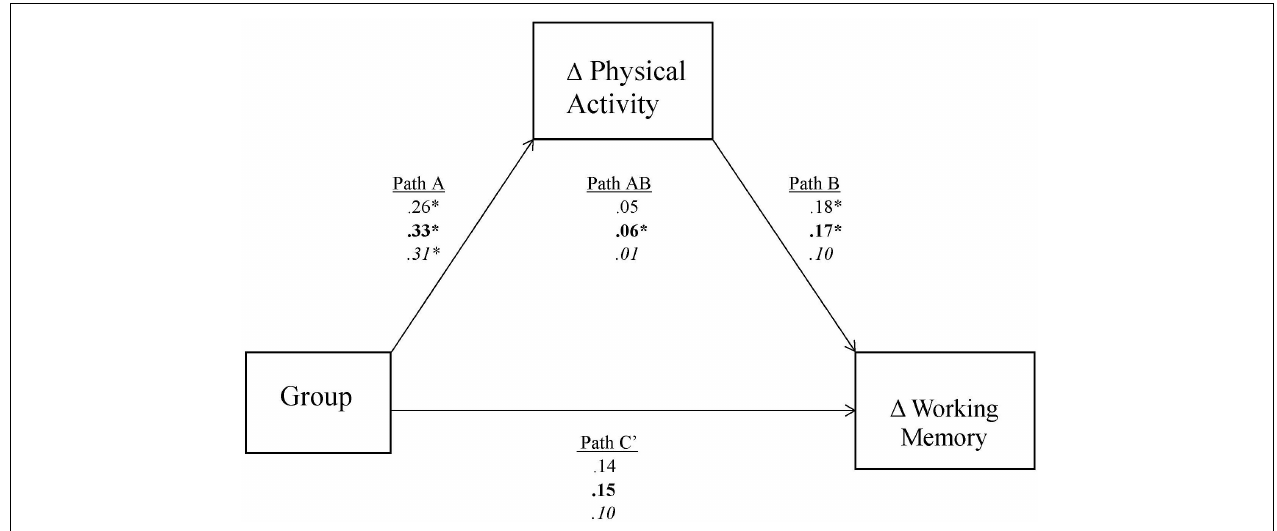
FIGURE 1 | Mediation model. Coefficients in standard font, bolded font, and italics represent total physical activity time, total leisure time physical activity, and moderate-to-vigorous physical activity, respectively. ∗ Significance at p < 0.05. Group compares experimental vs. control